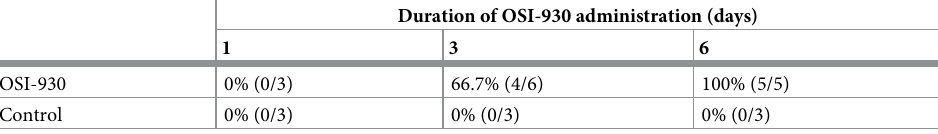
Table 1. Rates of hemorrhage in pituitary grands after OSI-930